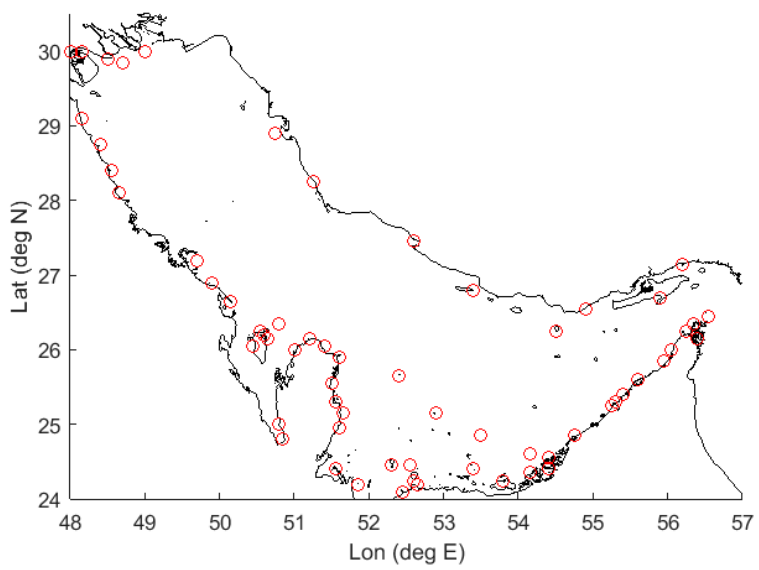
Figure 7. Tidal gage data locations used for calibration of Delft3D model.